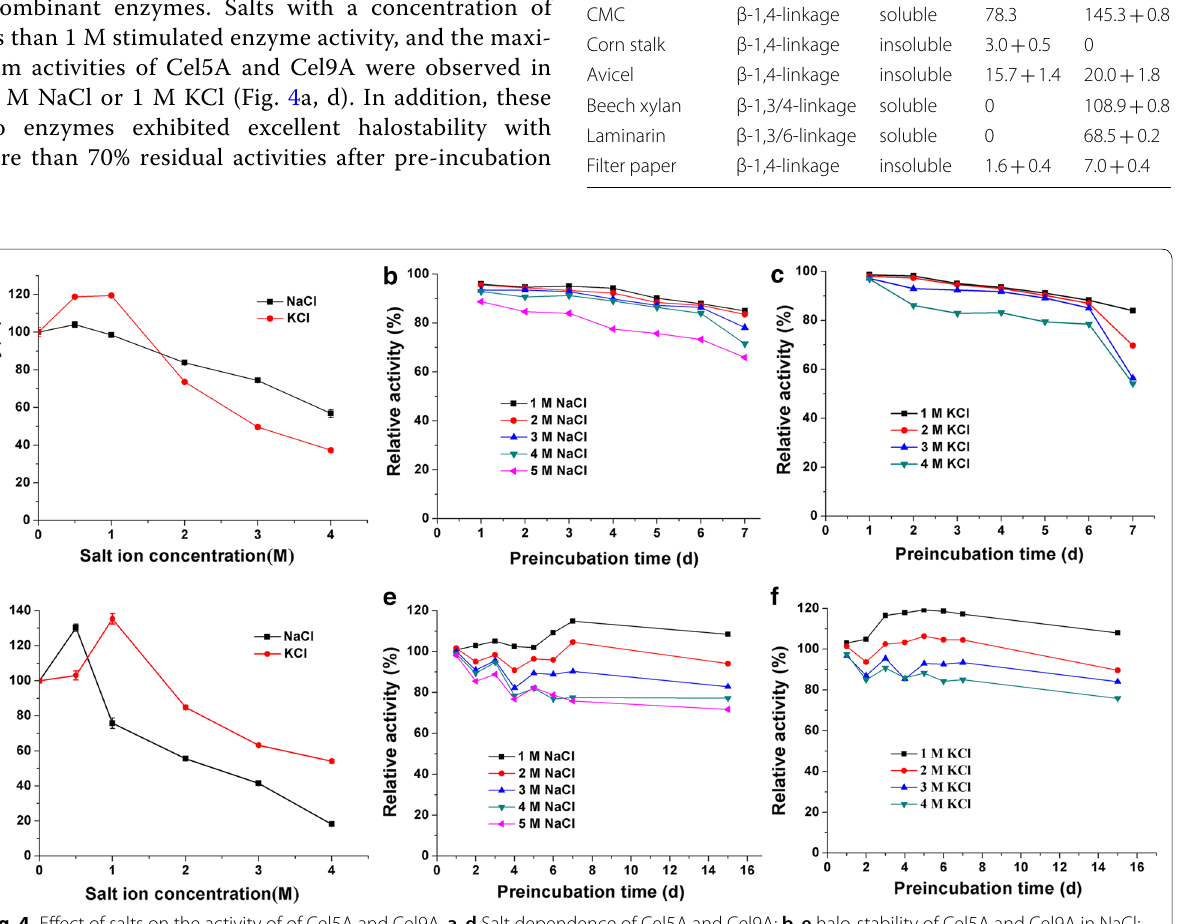
Fig. 4 Effect of salts on the activity of of Cel5A and Cel9A. a , d Salt dependence of Cel5A and Cel9A; b , e halo-stability of Cel5A and Cel9A in NaCl; c , f halo-stability of Cel5A and Cel9A in